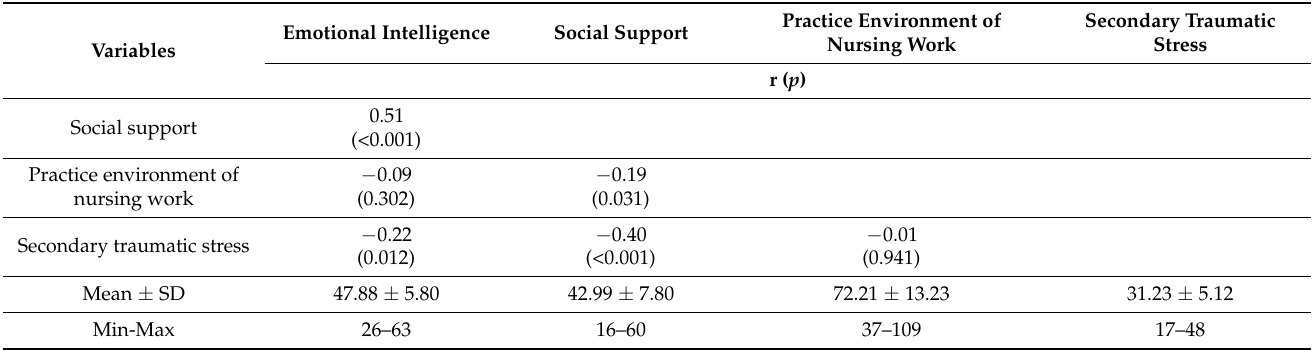
Table 2. Correlations among secondary traumatic stress, emotional intelligence, social support, and practice environment of nursing work (N =